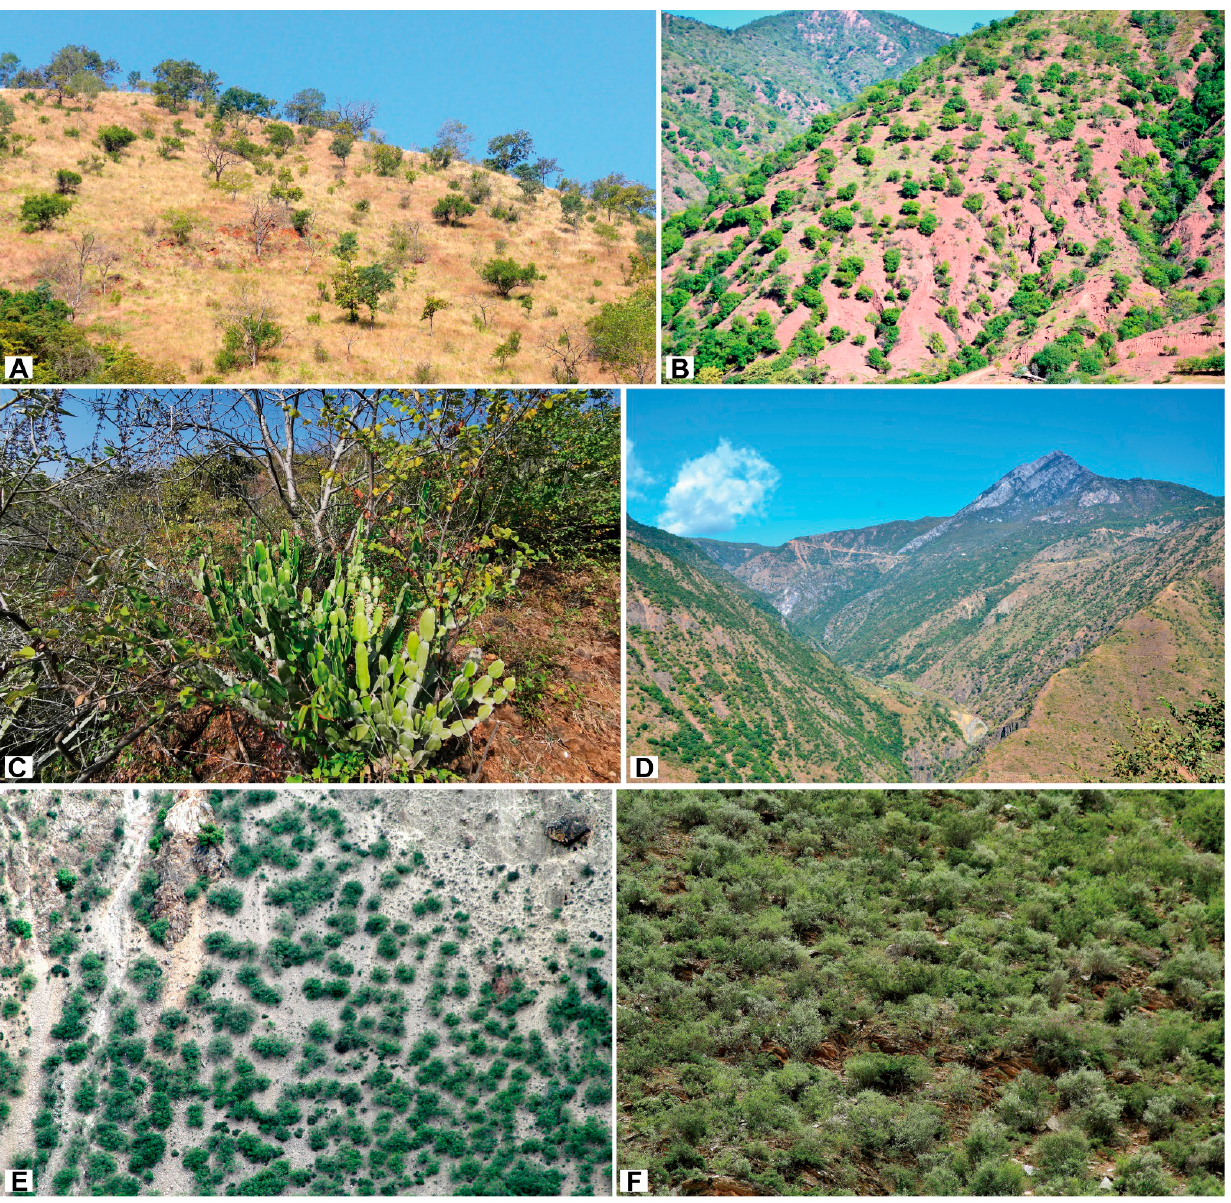
Figure 6. ( A ), Savanna ‐ like vegetation in hot dry valleys in southeastern Yunnan; ( B ), savanna ‐ like shrubs in hot dry valleys in southeastern Yunnan; ( C ), succulent shrubs in hot dry valleys in southeastern Yunnan; ( D ), savanna ‐ like vegetation in hot dry valleys in northern Yunnan; ( E ), maquis ‐ like vegetation in warm dry valleys in northern Yunnan; ( F ), close up of the maquis ‐ like vegetation in warm dry valleys in northern Yunnan.